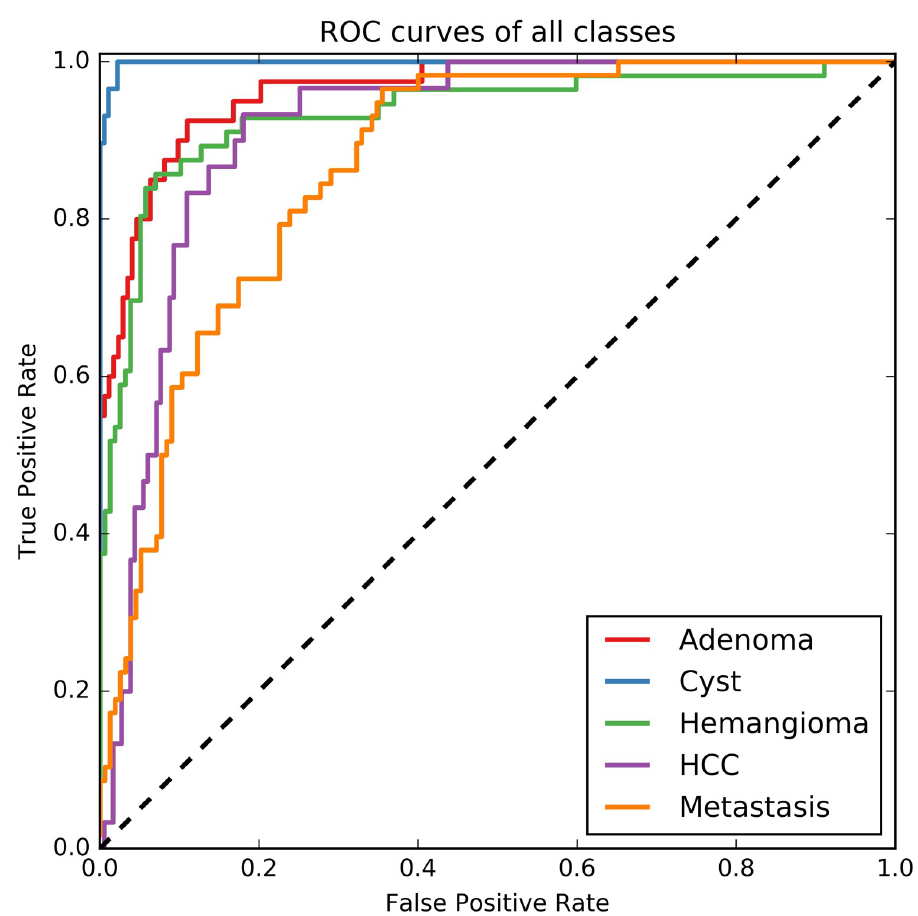
Fig 3. ROC curves of all lesion classes in a one-versus-other approach. The rest class is calculated as the outcome probabilities of the other four lesions.